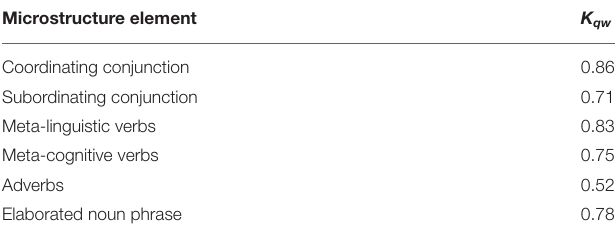
TABLE 3 | K qw for hand-scores (expert and non-expert).